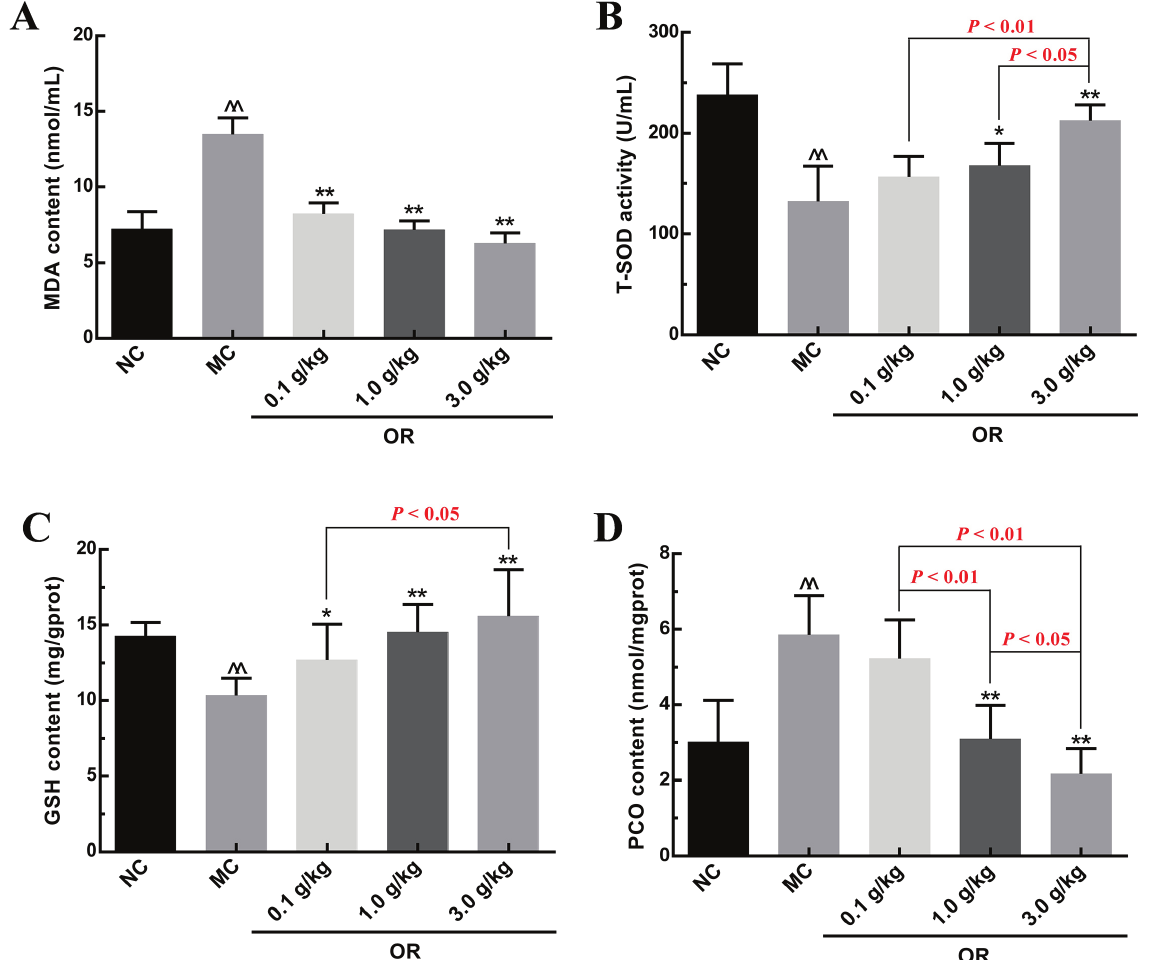
FIGURE 1 - Effects of OR on (A) MDA, (B) T-SOD, (C) GSH, and (D) PCO. Data denoted are means + SD (n = 10). Different symbols indicated statistically significant differences. ^^ P < 0.01 compared with the NC group; * P < 0.05 compared with MC group; ** P < 0.01 compared with the PC group. MDA, malonaldehyde; T-SOD, total superoxide dismutase; GSH, glutathione; PCO, protein carbonyls; OR, Oviductus ranae; NC, normal control; MC, model